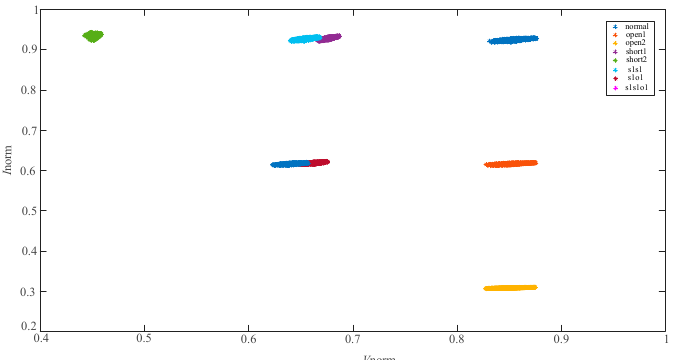
Sensors 2019 , 19 , 1520 Figure 4. The distribution of the 8 fault characteristic points ( )